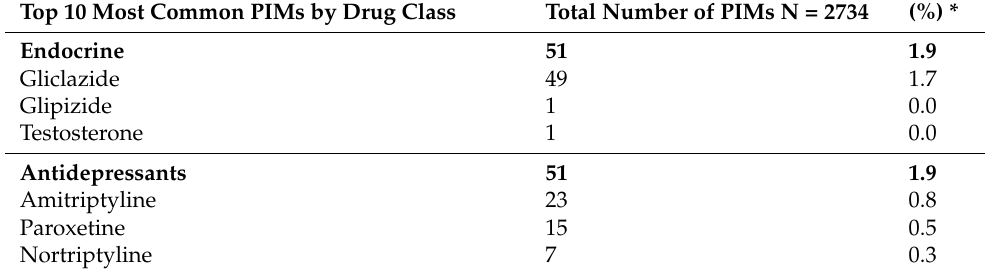
Table 3. Cont. Top 10 Most Common PIMs by Drug Class